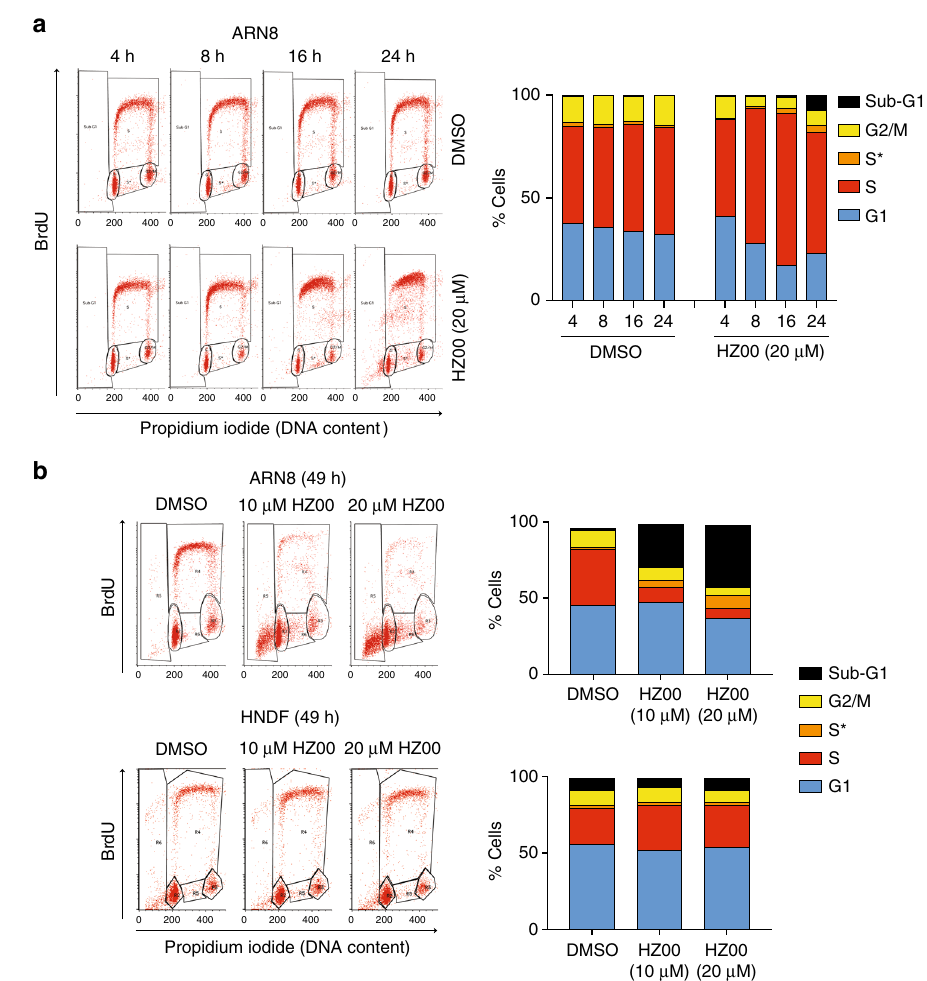
Fig. 3 HZ00 accumulates cancer cells in S-phase. a , b ARN8 or HNDF cells were treated with HZ00 for the indicated times and analyzed by BrdU/PI fl ow cytometry with the percentage in each cell cycle phase graphed. S* indicates cells with a DNA content between 2N and 4N that do not incorporate